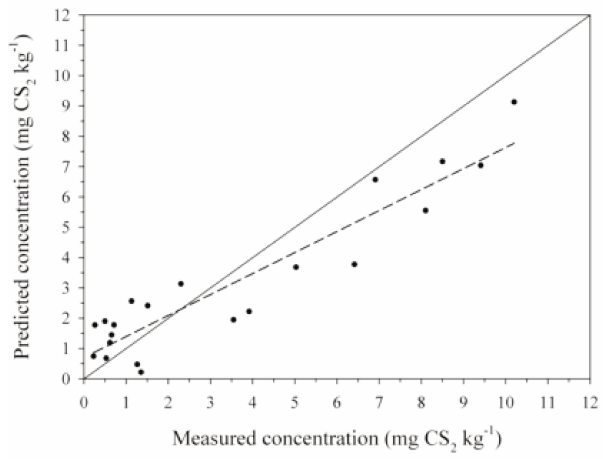
Fig. 3 ­ External validation of the PLS model for estimating dithiocarbamate concentrations (mg CS leaves.